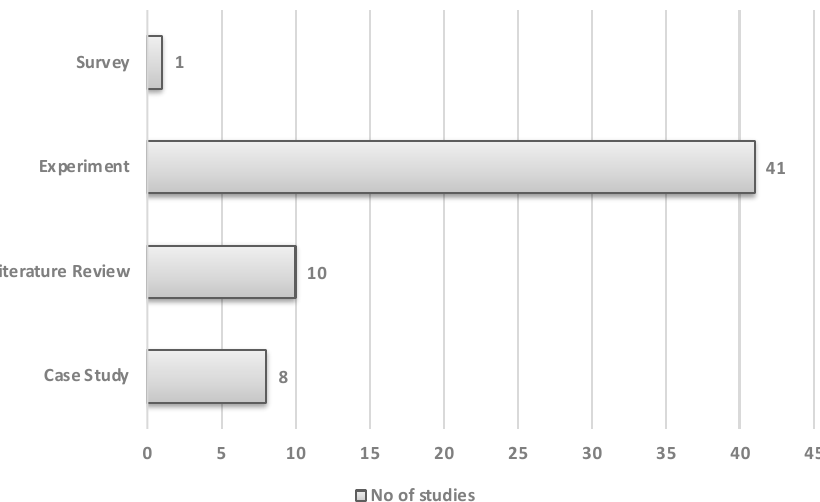
Figure 3. Research strategies used in the published studies.